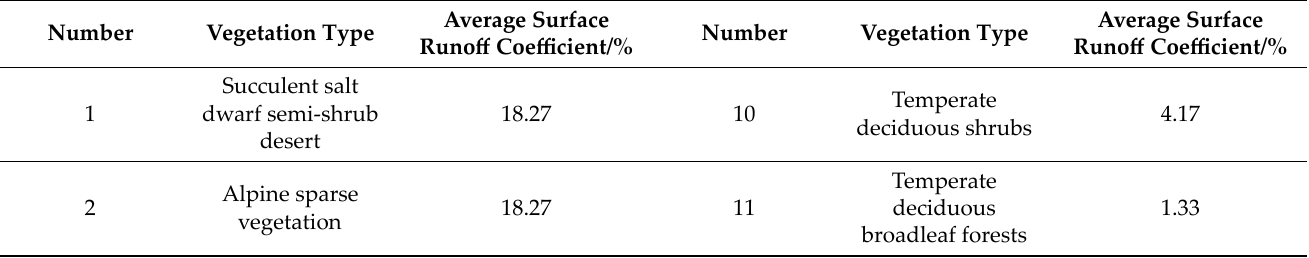
Table 3. Relationship between vegetation types and surface runoff coefficient in TheHehuang